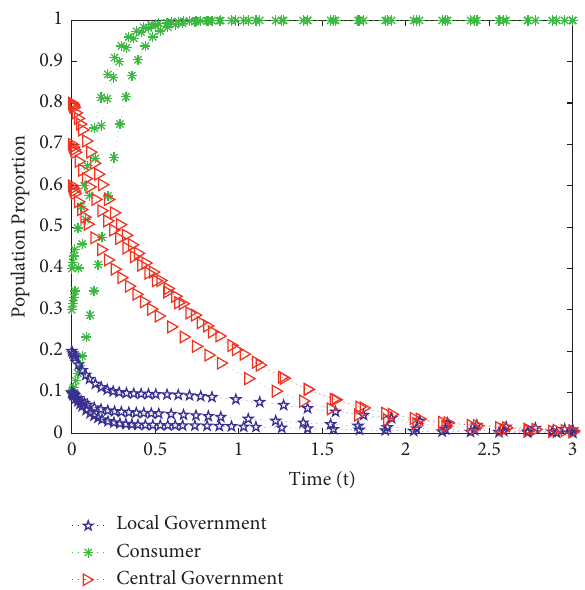
Figure 10: Evolution path of strategies chosen by three players with the stability point E 3